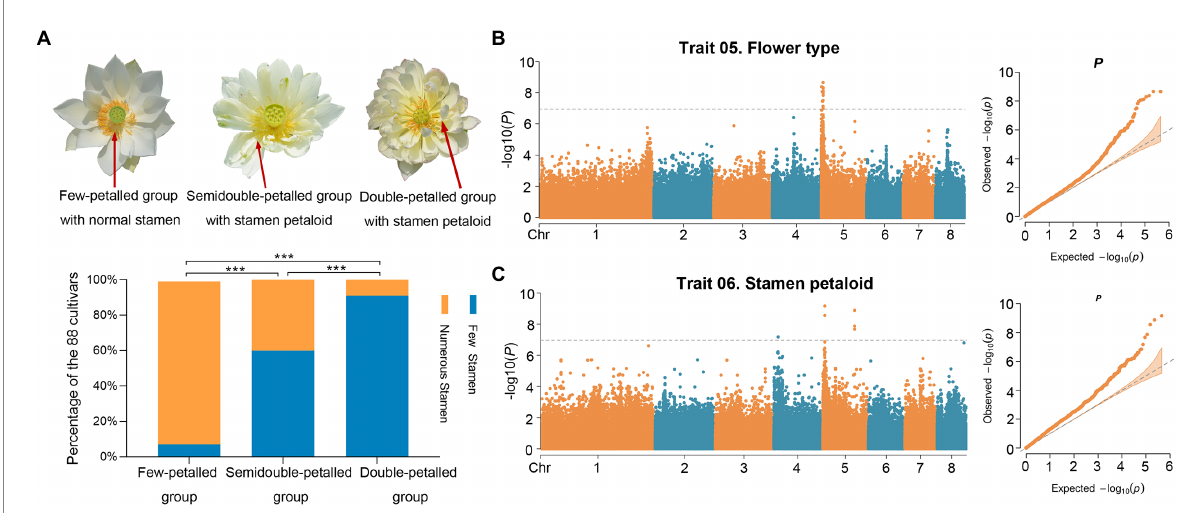
FIGURE 3 GWAS of flower type and stamen petaloid. (A) The relationship between stamen numbers and flower types with petal numbers in different groups (***, value of p < 0.0001). The three images displayed flowers in lotus with different flower types and stamen petaloid numbers. Red arrows point to the stamens and stamen petaloid. (B,C) Manhattan (left) and QQ (right) plots of GWAS results for flower type (B) and stamen petaloid (C) using a generalized linear model ( GLM ). The gray dotted lines and gray solid lines represent significance levels [***, − log10( P ) = 6.9, value of p =